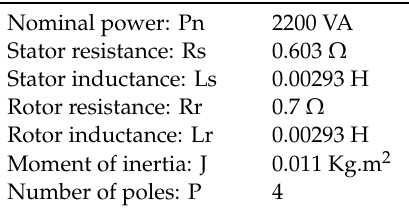
Table 3. Induction motor parameters.